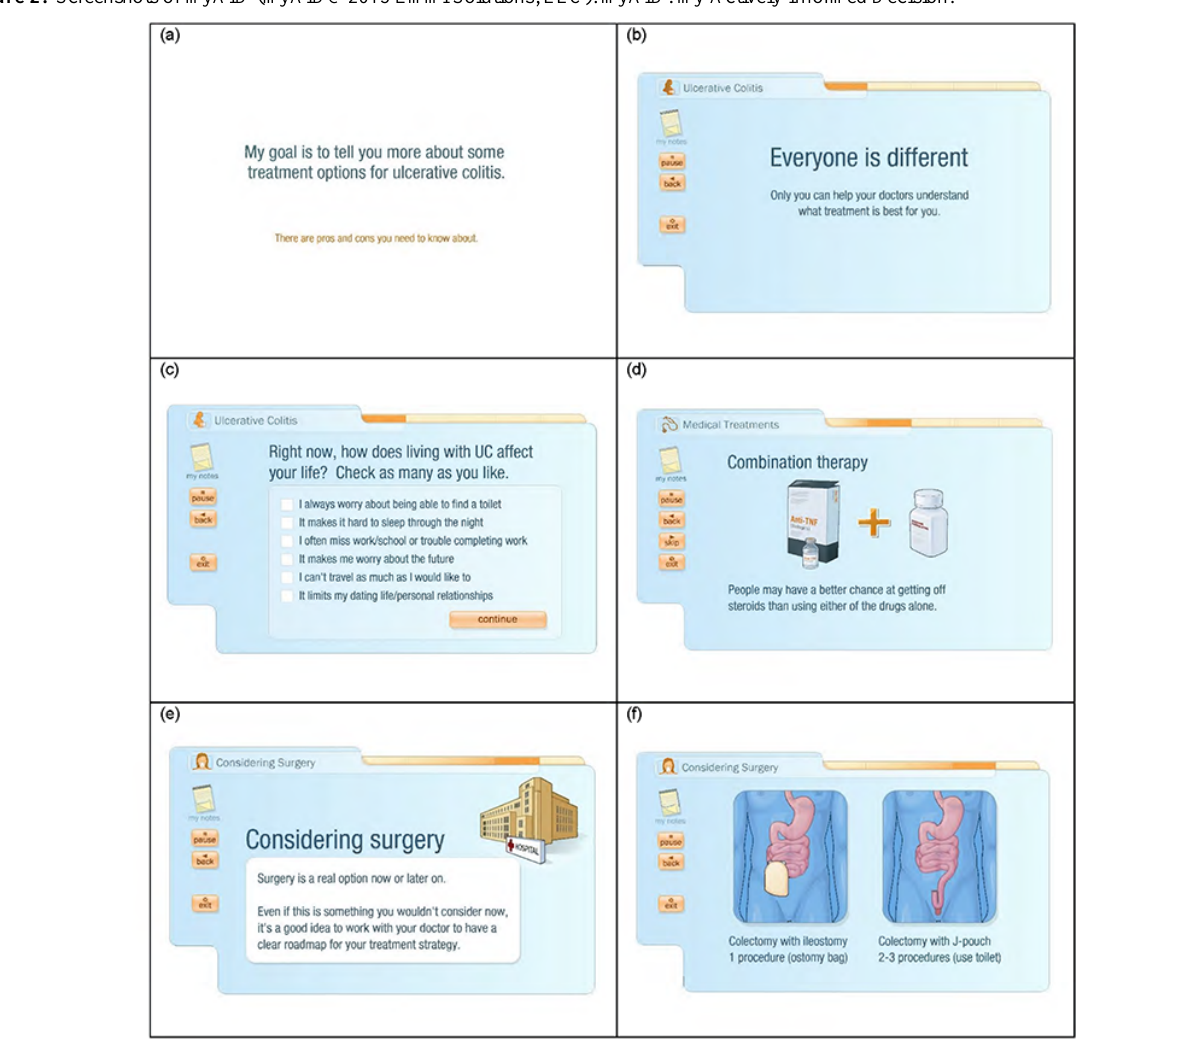
Figure 2. Screenshots of myAID (myAID@2015 Emmi Solutions, LLC). myAID: my Actively Informed